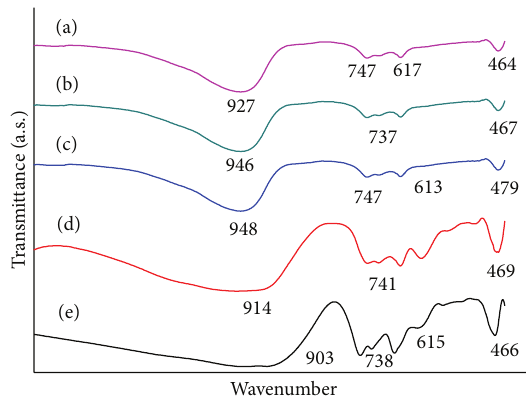
Figure 2: FTIR spectra of synthesized samples using fumed silica as silica source, (a) sodalite without template, (b) organosilane (c) TPA, (d) CTABr, and (e) TPA and CTABr 1 :1 as